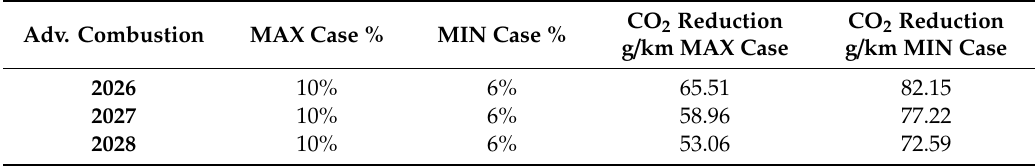
Table 7. CO 2 Reduction in Advanced Combustion